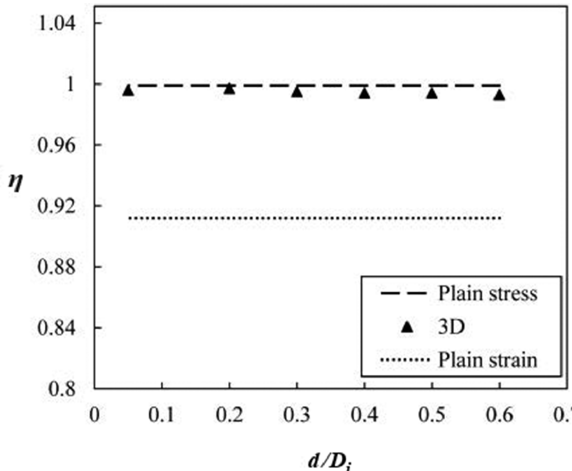
Figure 11: Finite element mesh and the boundary conditions for the TBS model.